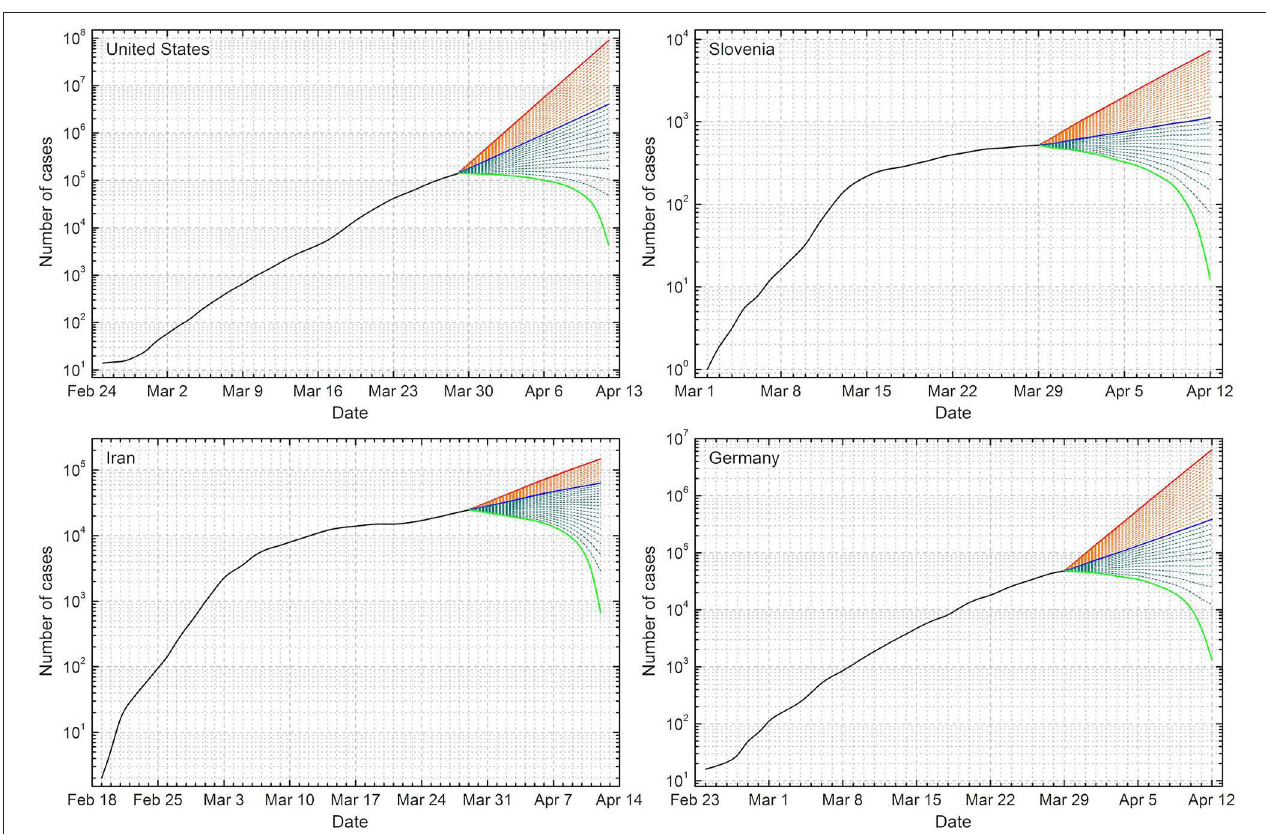
FIGURE 1 | Forecasts of COVID-19 cases for the United States, Slovenia, Iran, and Germany. Black solid line denotes the actual data, which were for this analysis last updated March 29th. From this date onward we thus have the predicted values, where the solid blue line denotes the continuation of the trend of the past 14 days, i.e., if nothing would change. The uppermost solid red line denotes the prediction obtained if the maximal daily growth rate recorded during the past 14 days G ↑ would increase by 20%, while the lowermost green line denotes the prediction if the daily growth rate would drop to zero from March 29th onward. Orange and olive dashed lines denote predictions for equally spaced decreasing daily growth rates from top to bottom. Plateaus in the next 14 days would be reached if: United States target daily growth rate ≈ 5.9 % (4th line from the bottom), Slovenia target daily growth rate ≈ 3.7 % (7th line from the bottom), Iran target daily growth rate ≈ 3.6 % (10th line from the bottom), and Germany target daily growth rate ≈ 5.5 % (5th line from the